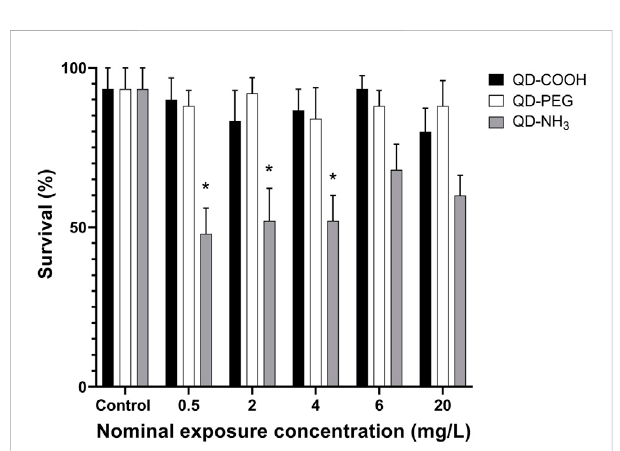
FIGURE 5 Survival of Danio rerio larvae after 96 h of exposure to QD- COOH, QD-PEG and QD-NH 3 . Error bars represent standard deviation. Single asterisk (*) indicates differences from control ( p <